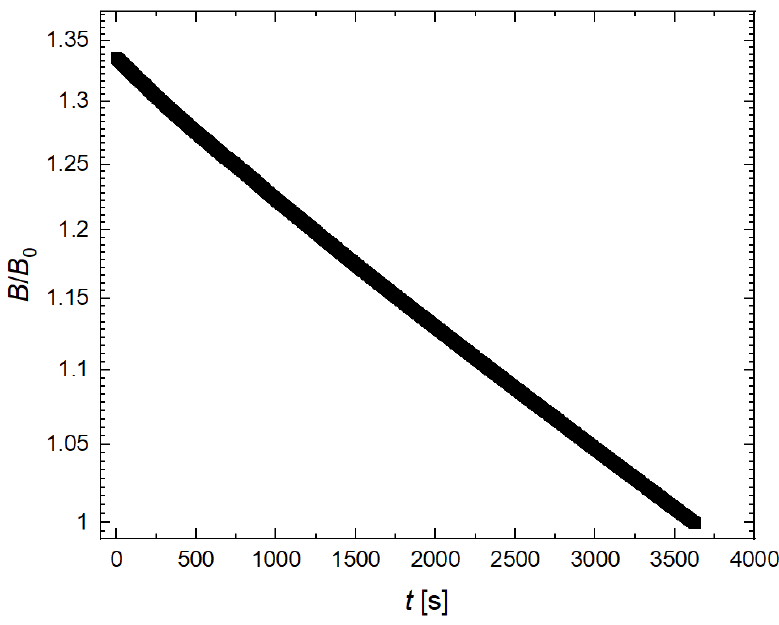
Figure 13. Normalized decay curve of the magnetic flux of the DP module under open-loop condition.